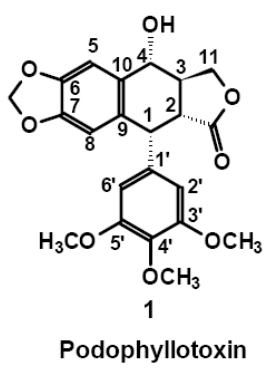
Fig. 1 Structure of